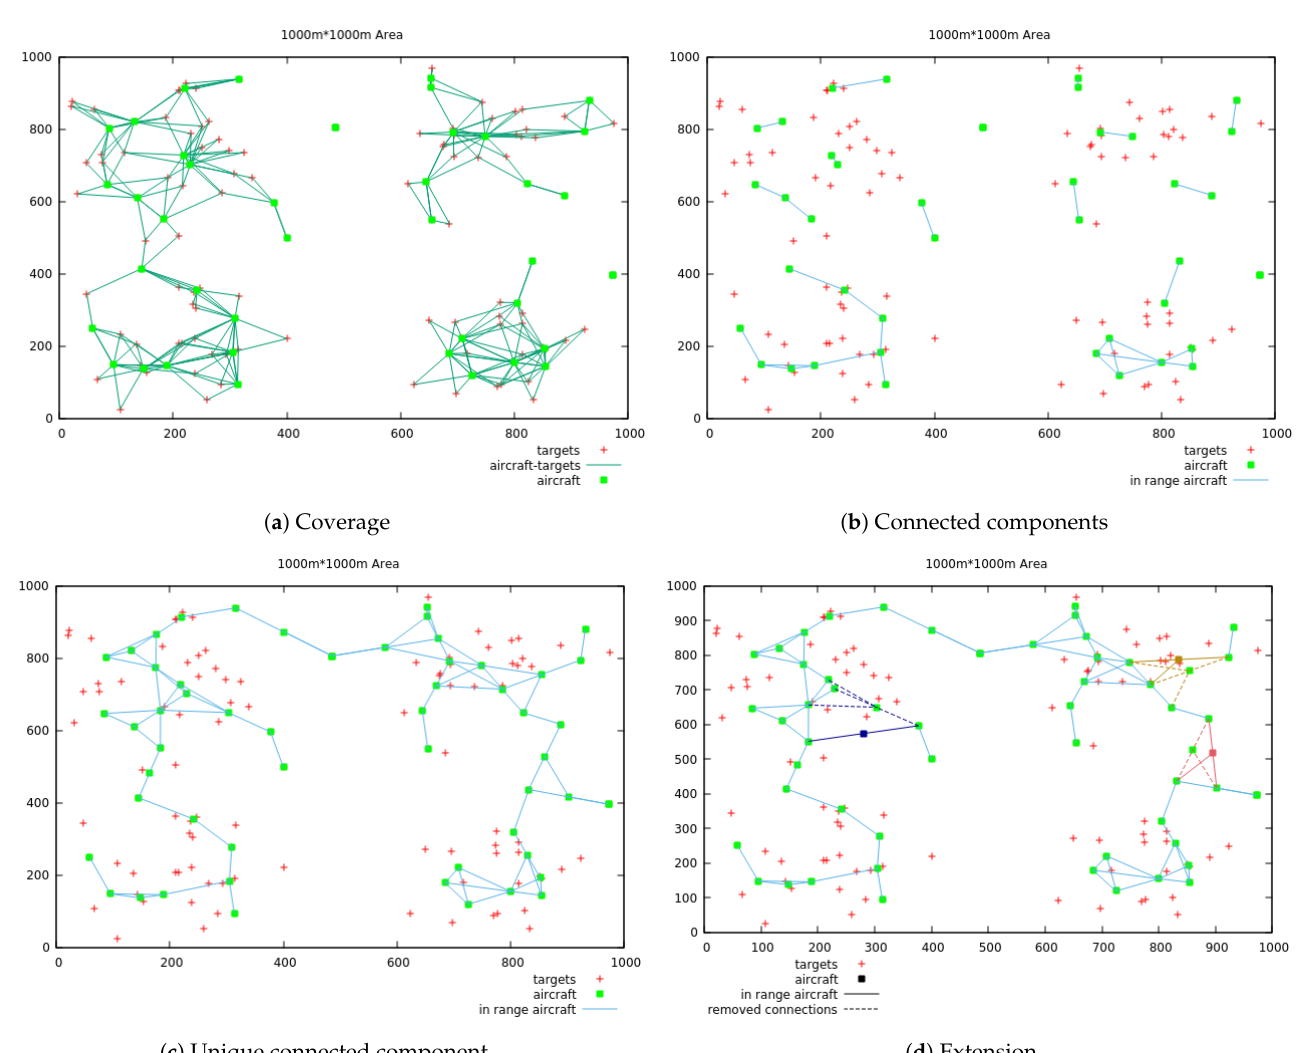
Figure 5. Stages of building a connected